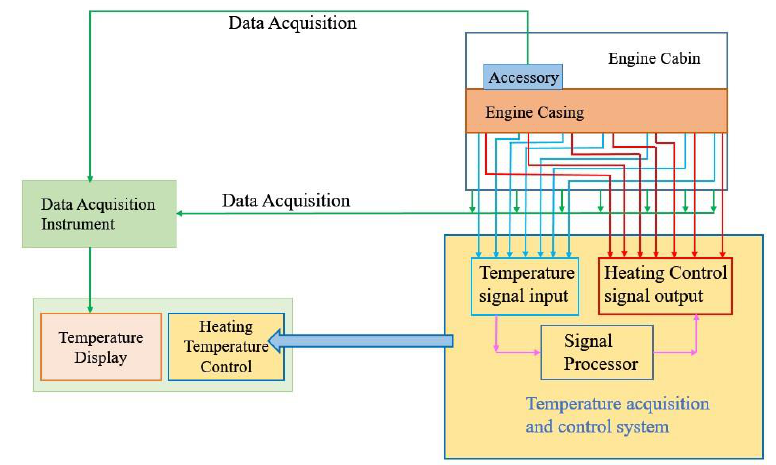
Figure 6. Experimental system schematic diagram.